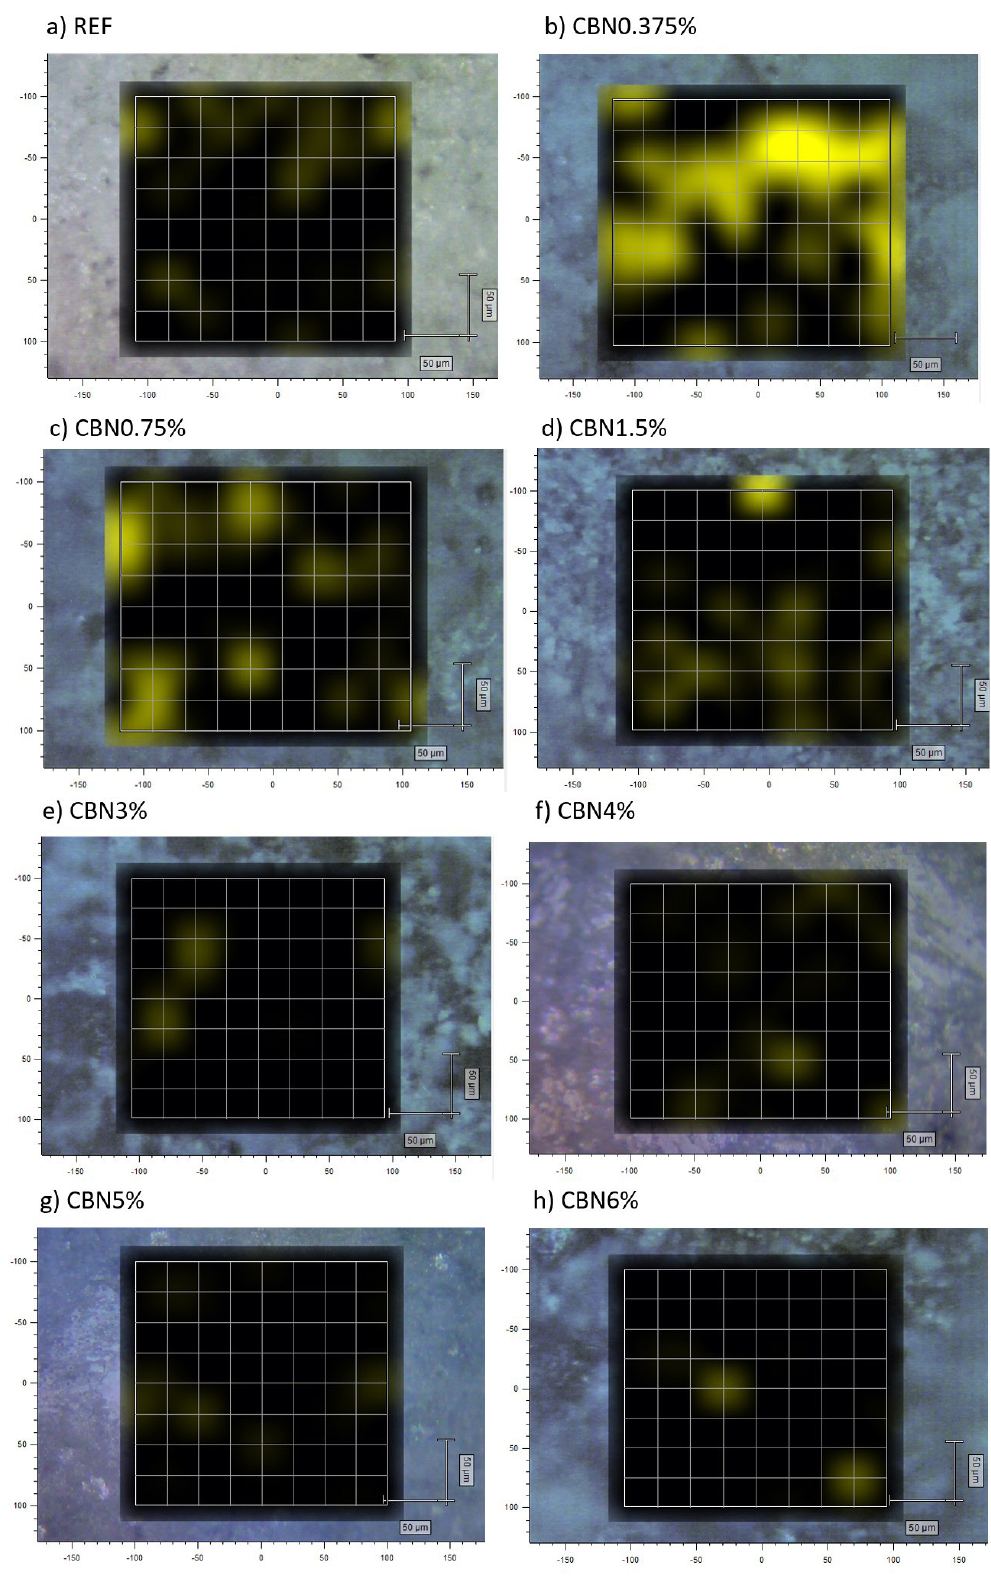
Figure 5. Raman maps for portlandite peaks at 356.63 cm -1 (brighter spots indicate higher peak intensities) of a cementitious matrix with different CBN contents at 28